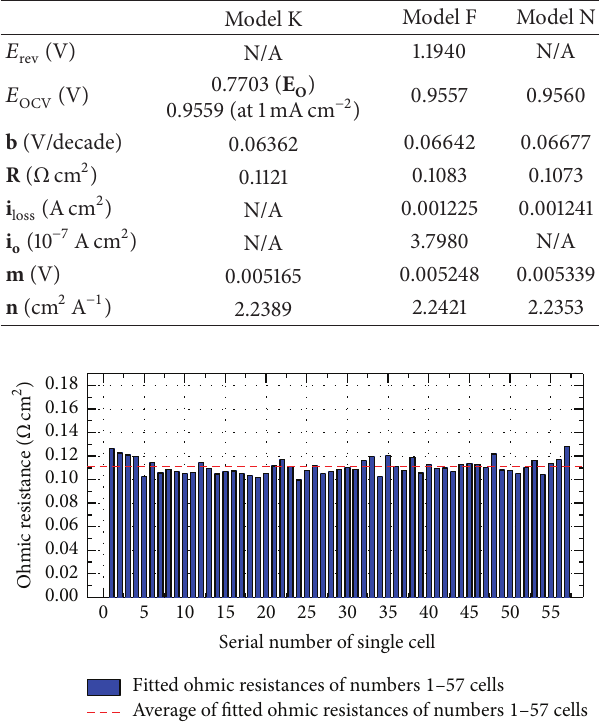
Figure 5: Fitted ohmic resistances of 57 single cells.